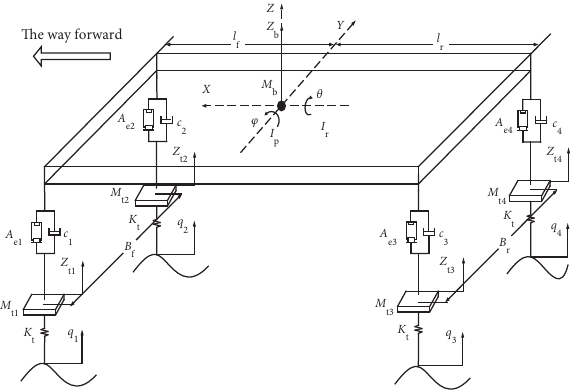
Figure 4: Establishment of the vehicle